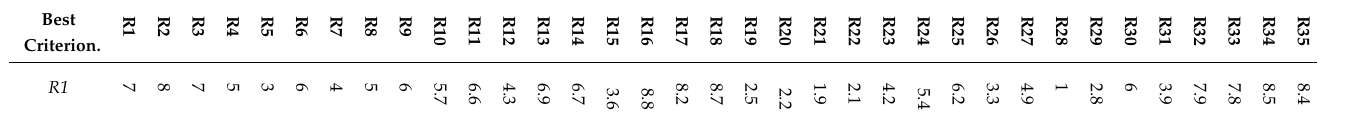
Table 4. Criteria Best-to-Others (BO)